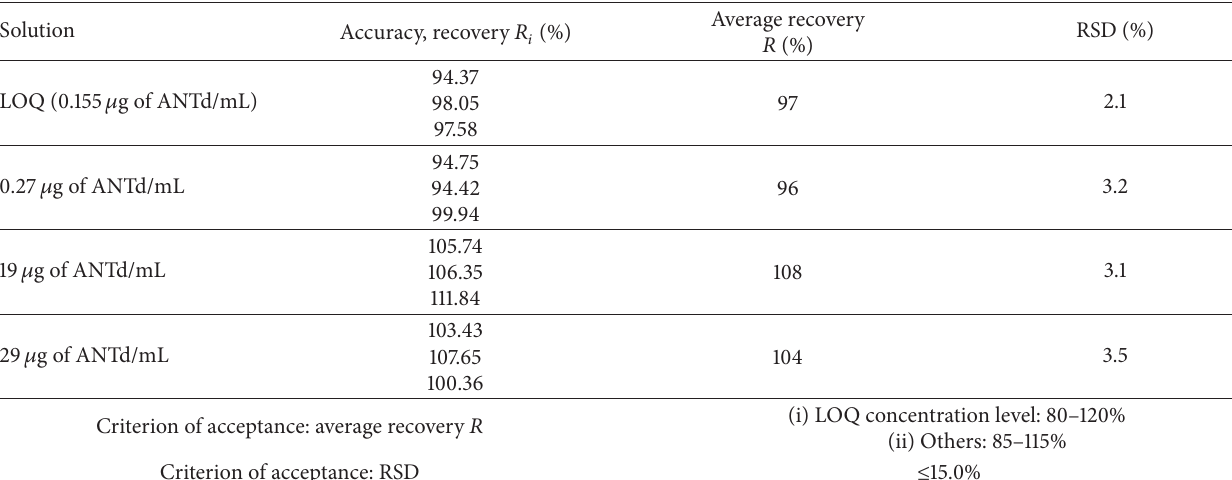
Table 3: Results of accuracy/swabs of stainless steel.